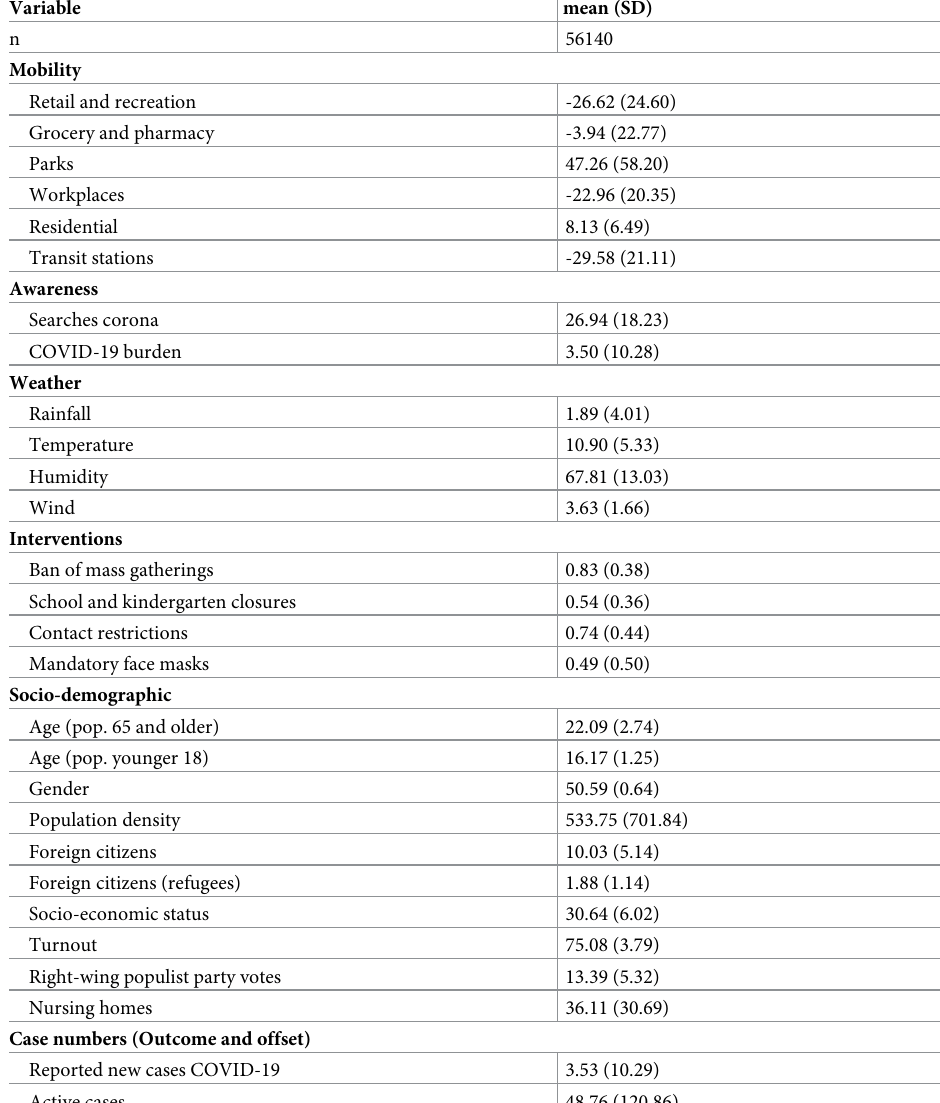
Table 2. Descriptive statistics for observed